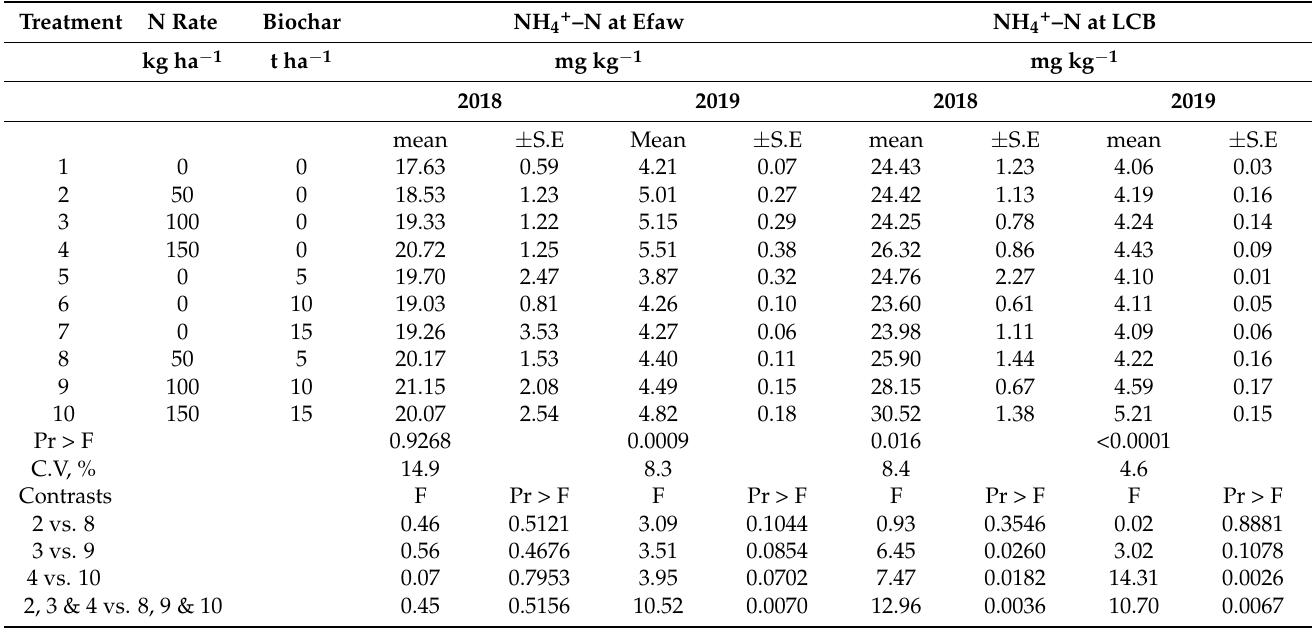
Table 3. Mean ammonium N for treatments plus the associated contrasts between N fertilizer and biochar-N combinations at Efaw and Lake Carl Blackwell, Stillwater, Oklahoma. 2018 and 2019.